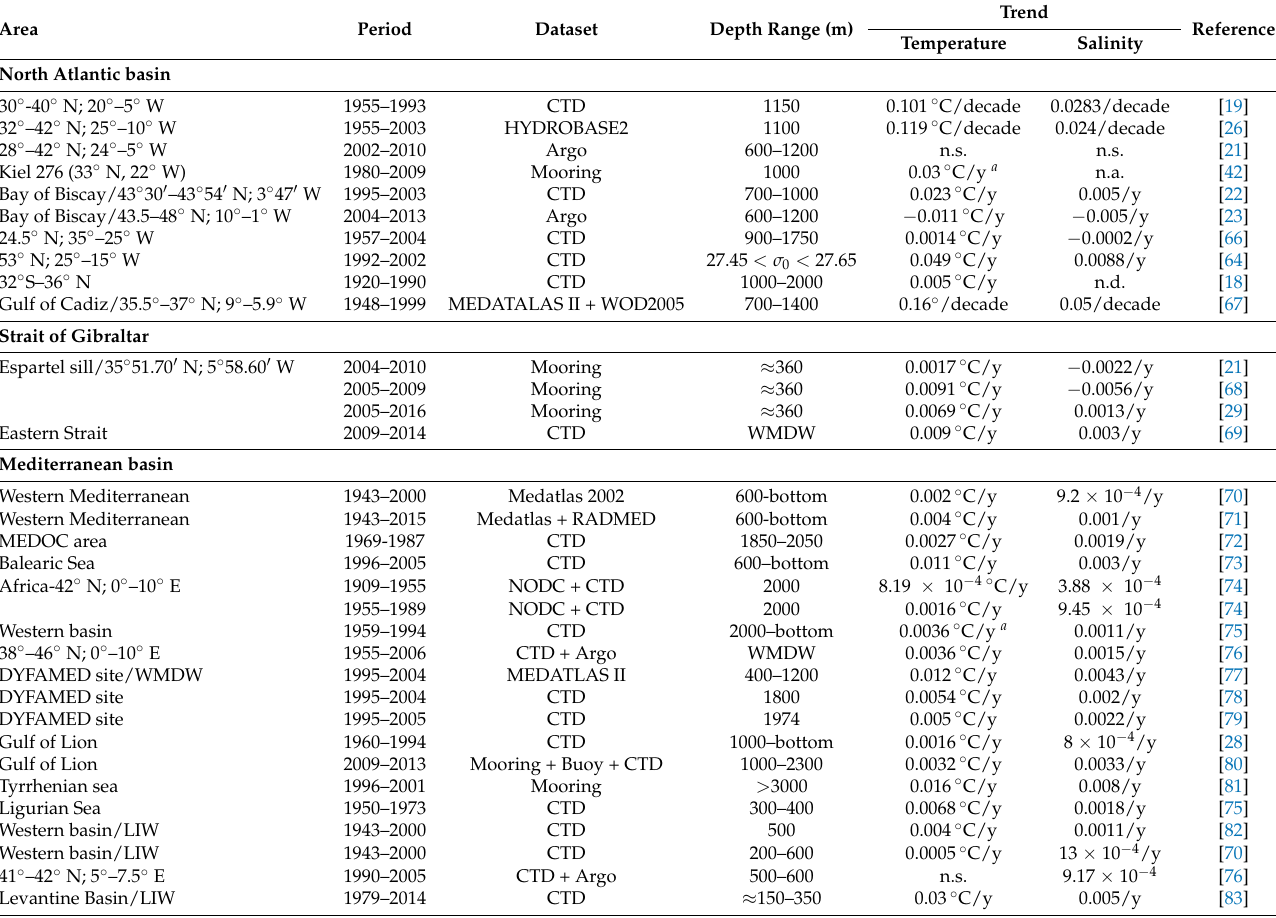
Figure 4. ( a ) Salinity distribution averaged at the core of Mediterranean Outflow Water (MOW) (1000–1100m) from the World Ocean Atlas (WOA18 in [33]) between 1965–1974 and ( b ) between 1985–1994. ( c ) Salinity difference between the periods 1965–1974 and 1985–1994. Table 2. Summary of in situ potential temperature and salinity trends in the Northeast Atlantic basin, at the Strait of Gibraltar and in the Mediterranean Sea. The period refers to the considered time span for which the trends were calculated. The dataset gives the source used. n.s.: trends are not significant; n.a. not applicable in the considered